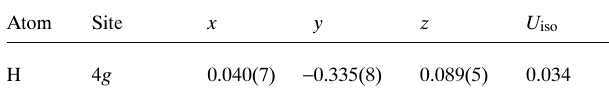
Table 2. Atomic coordinates and displacement parameters (in Å 2 )